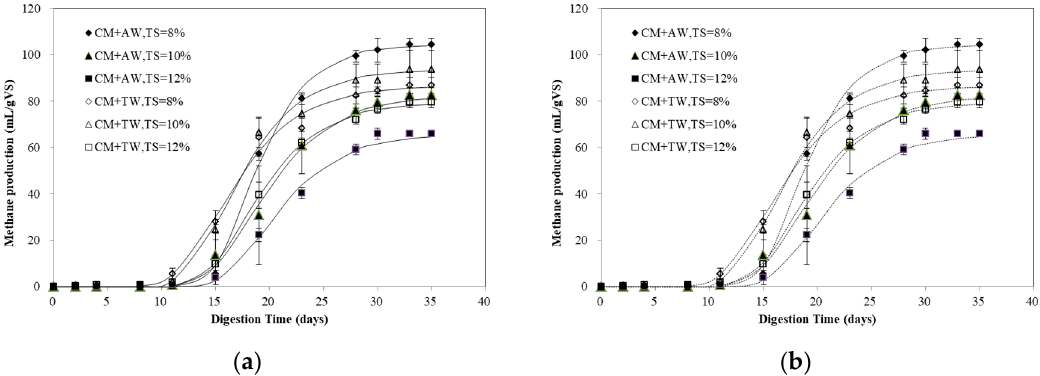
Figure 1. Methane accumulation fitted by the modified Gompertz model ( a ) and logistic model ( b ).